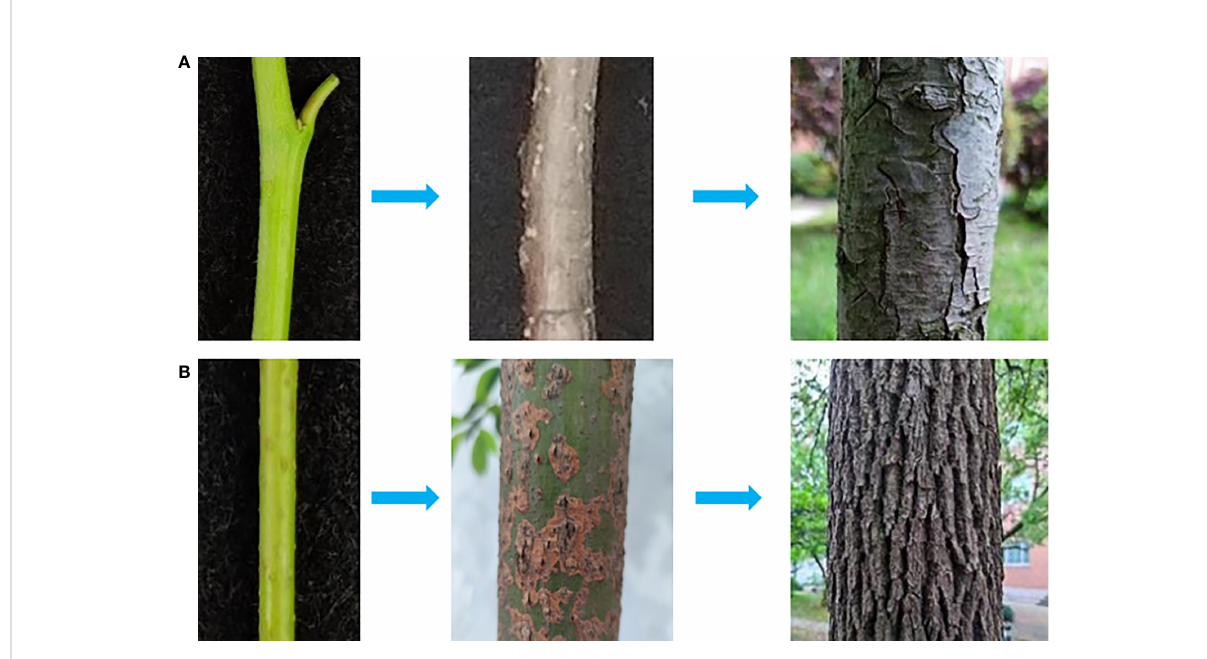
FIGURE 4 Different types of stem periderm. In the direction of the arrow, the new spring stem, biennial stem, and perennial stem of sand pear ( Pyrus pyrifolia) (A) and camphor tree ( Camphora of fi cinarum ) (B) could be observed.